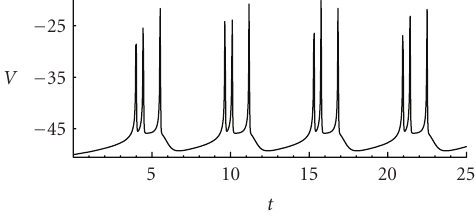
Figure 2.8. Time sequence of membrane potentials for g K , C = 15 . 0 s − 1